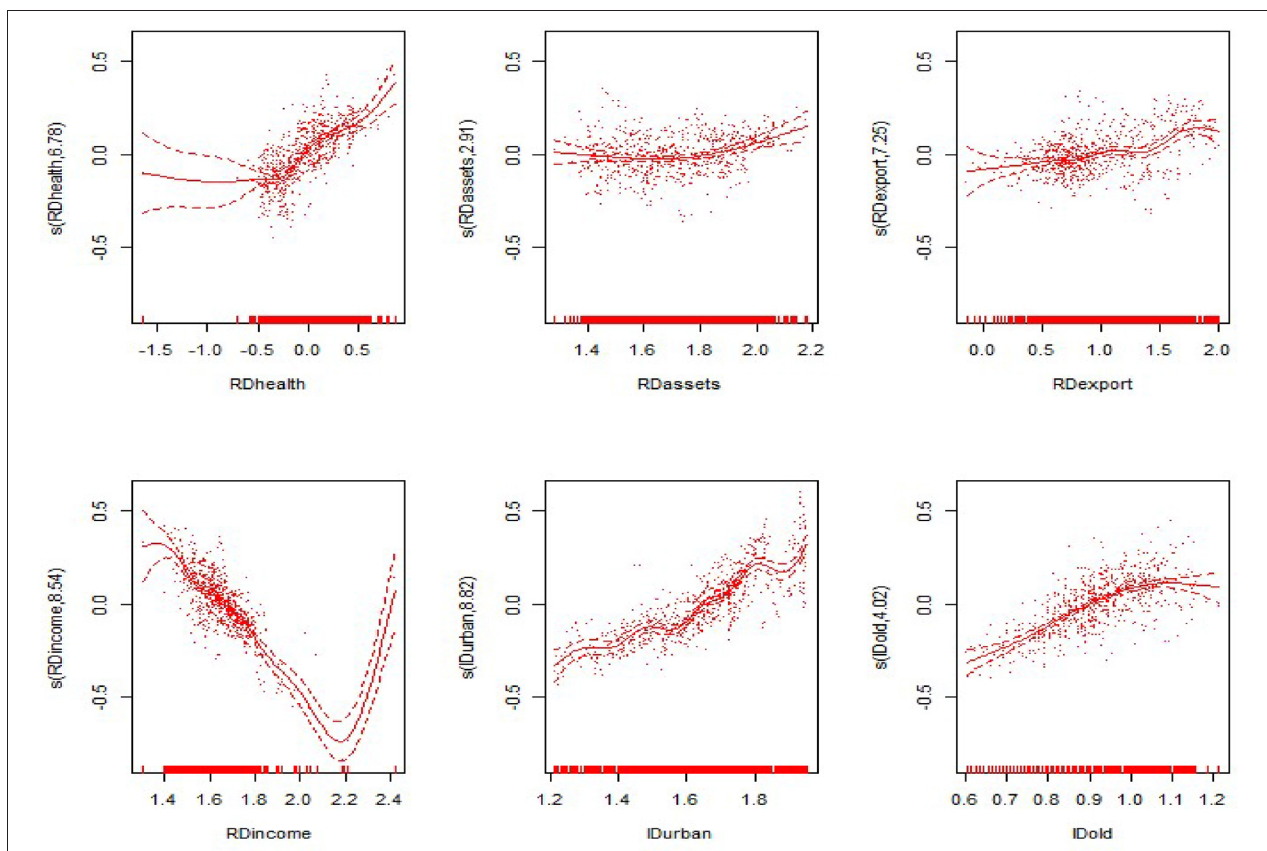
FIGURE 7 | Comprehensive effects of the explanatory variables on per capita GDP in the